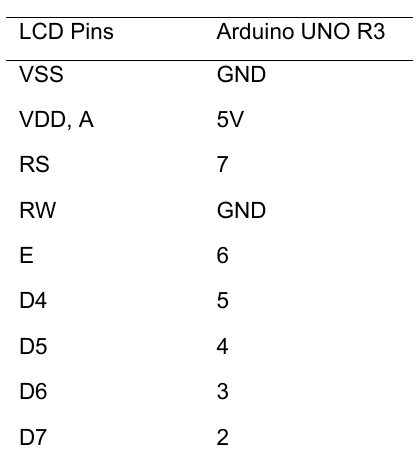
Table 2. Pin connections of LCD with Arduino